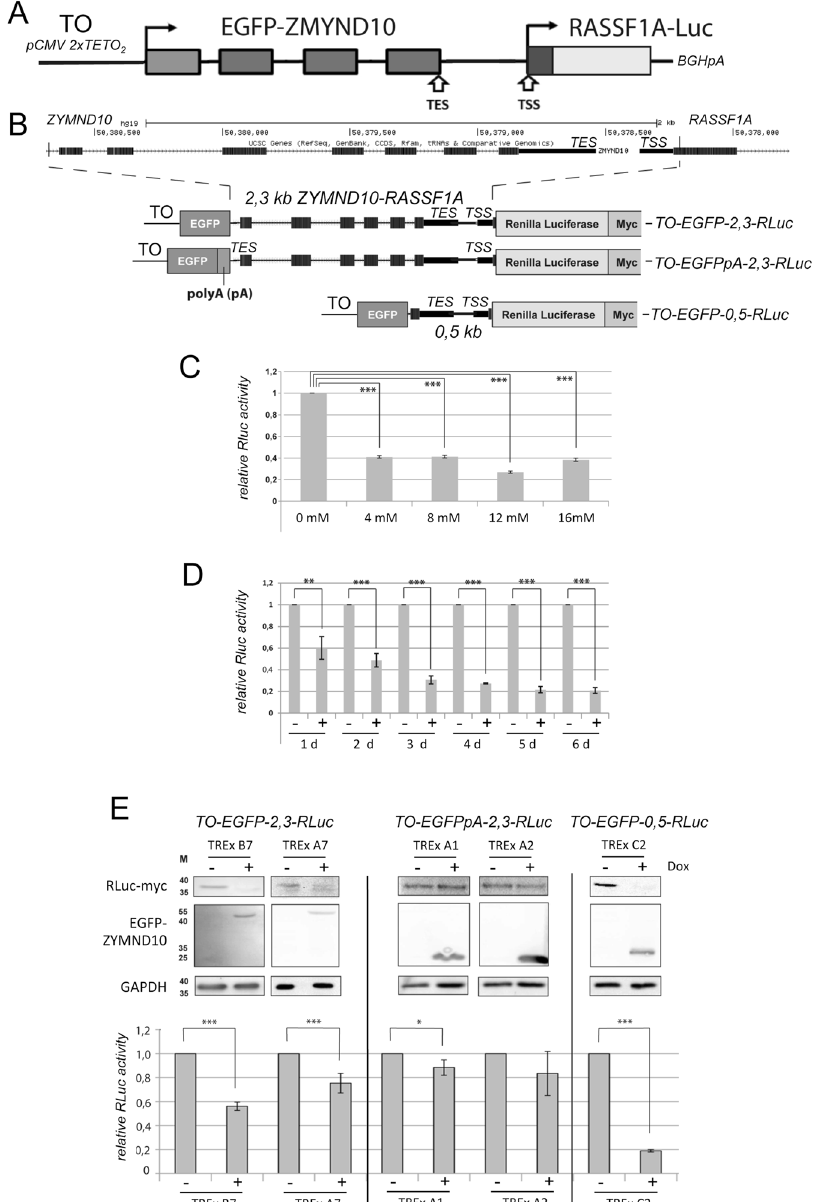
Figure 5. Induction of an upstream gene correlates with the downregulation of a tandem oriented downstream promoter. ( A ) Outline of the tandem oriented reporter gene construct. The ZMYND10 - RASSF1A promoter including the ZYMND10 transcriptional end site (TES) and the RASSF1A promoter and transcriptional start site were cloned in a tetracycline inducible vector system (Tet -On/TO). The EGFP - ZYMND fusion gene was under the control of the pCMV 2xTETO 2 promoter and the 500 bp RASSF1A promoter including 5 ′ -UTR and 17 bp of Exon1 α was ligated in frame to Myc tagged Renilla luciferase (RLuc). ( B ) UCSC genome browser view of the 2.3. kb ZMYND10 - RASSF1A promoter locus. Black boxes represent exons. Outline of the genetic structure of the tandem reporter TO-EGFP-2,3-RLuc. In the construct TO-EGFPpA-2,3-RLuc a 300 bp SV40 poly A site (pA) was inserted at the 3 ′ -end of EGFP . To generate the tandem reporter TO-EGFP-0,5-RLuc a 1.8 kb fragment of ZYMND10 was deleted. ( C ) Luciferase assay of the TO-EGFP-2,3-RLuc construct. The tandem reporter was stably transfected into TREx293 cells and induced for four days with the indicated concentration of doxycycline (Dox). RLuc activity was analyzed as described in the methods section. ( D ) Time dependent downregulation of RLuc activity. TREx293 cells stably transfected with TO-EGFP-2,3-RLuc were induced with 4 mM Dox ( + ) or uninduced ( − ) for the indicated days (d) and RLuc activity was analyzed. ( E ) Analysis of different tandem constructs by western blot and luciferase assay. Two TREx clones (B7 and A7) of the stable transfected TO-EGFP-2,3-RLuc were induced with 4 mM Dox for four days and the protein levels were subsequently analyzed by western blot. Protein lysates were separated on SDS PAGE and blotted. Full- length blots are included in the supplementary information file. For detection of the indicated proteins primary antibody against myc, GFP and GAPDH were utilized. In parallel RLuc activity was analyzed with a